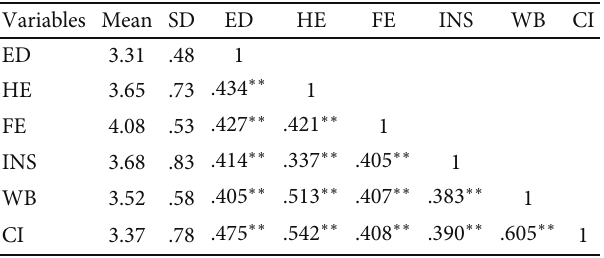
Table 4: Pearson correlation between study variables. Variables Mean